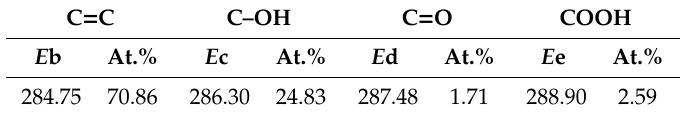
Figure 9. XPS spectra of the Cu coated braided carbon fiber rope: ( a ) survey XPS spectra; ( b ) Cu2p spectra.